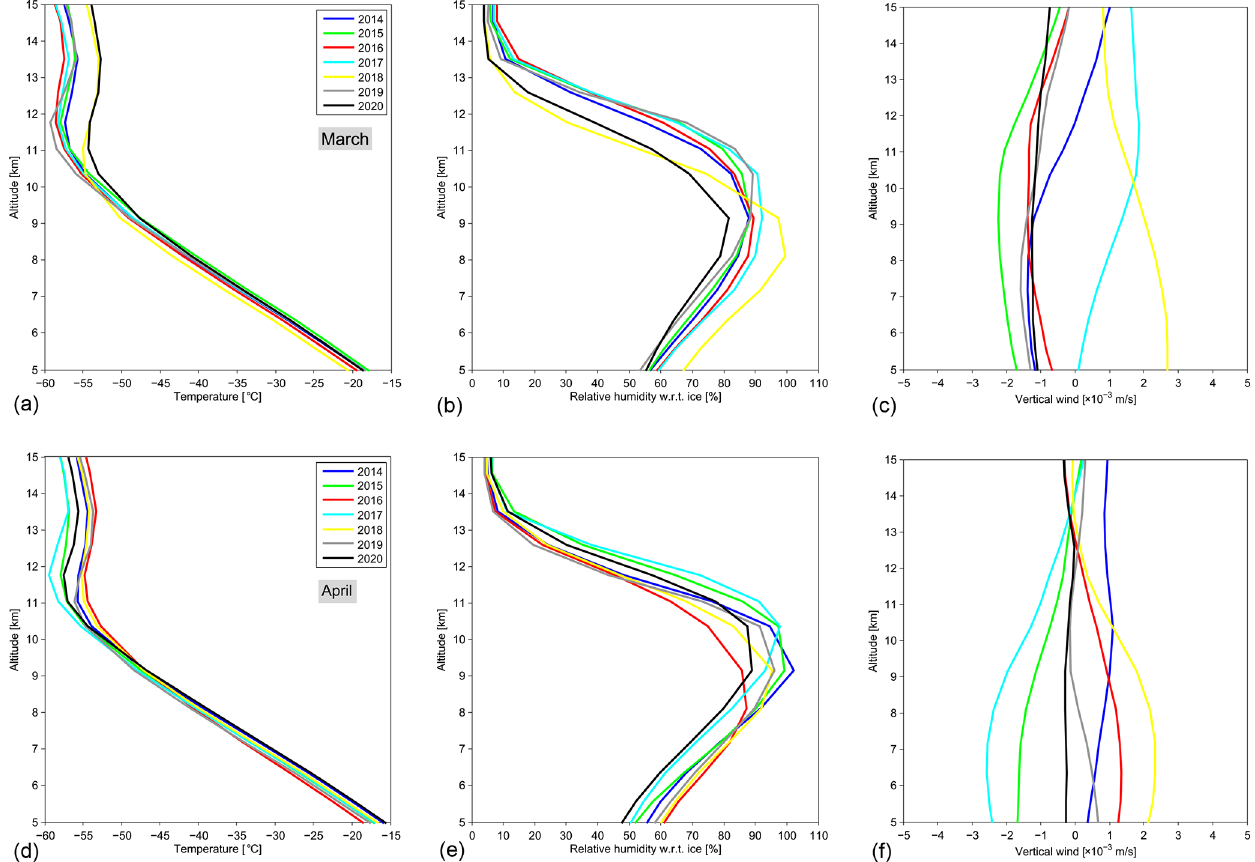
Figure 3. Altitude profiles of background temperature, relative humidity with respect to ice (RHi), and vertical updrafts derived from ERA5 reanalysis data over Europe (the same area indicated with the black boxes in Figs. 1 and 2). Panels (a) – (c) indicate the meteorological parameters in March and panels (d) – (f) in April.